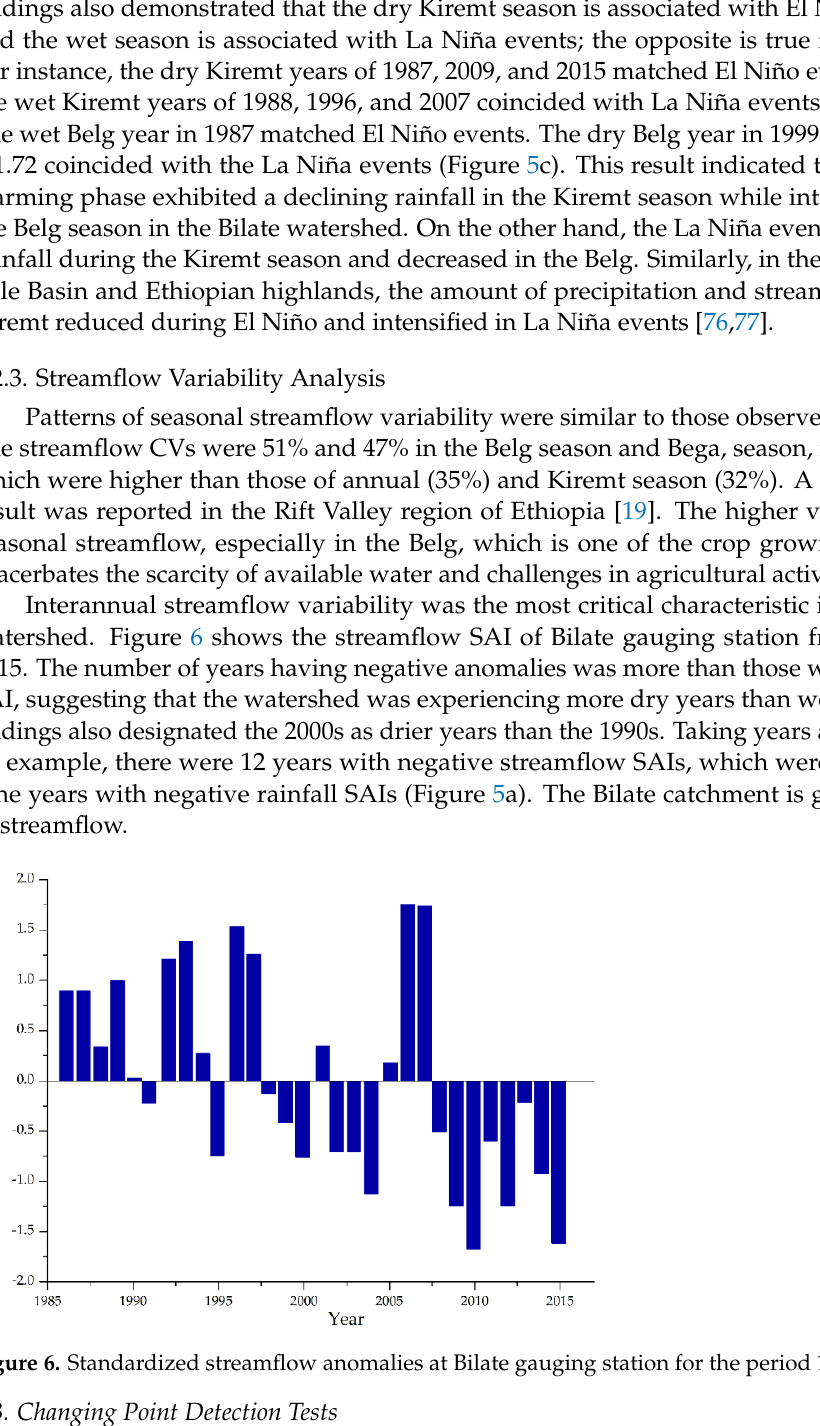
Figure 5. Standardized rainfall anomaly of the Bilate watershed for the period 1986–2015 for ( a ) the annual, ( b ) the Kiremt, ( c ) the Belg, and ( d ) the Bega seasons.